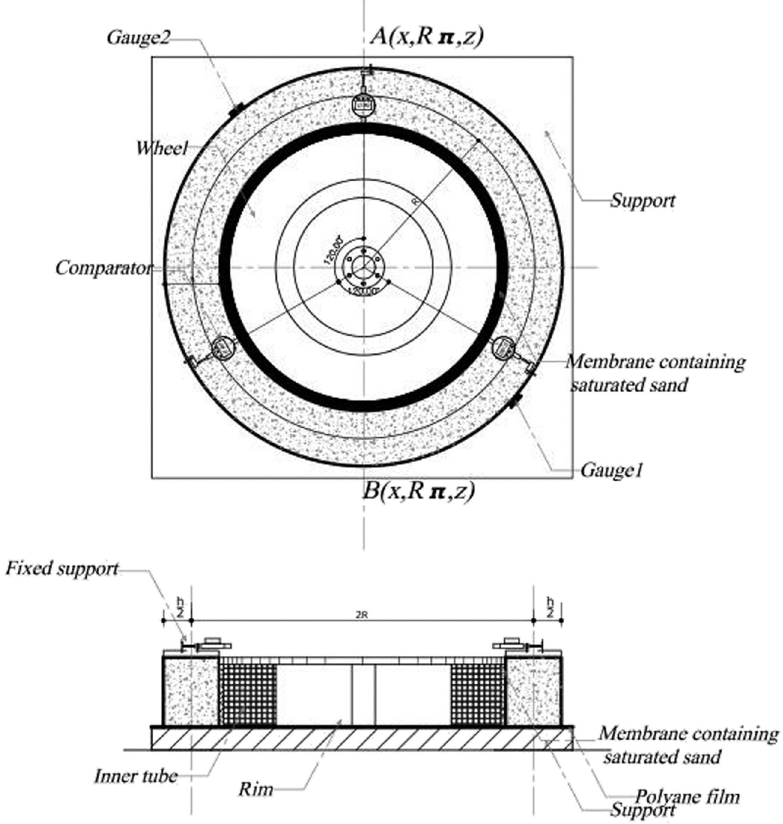
Figure 2: Geometry details of test specimen.